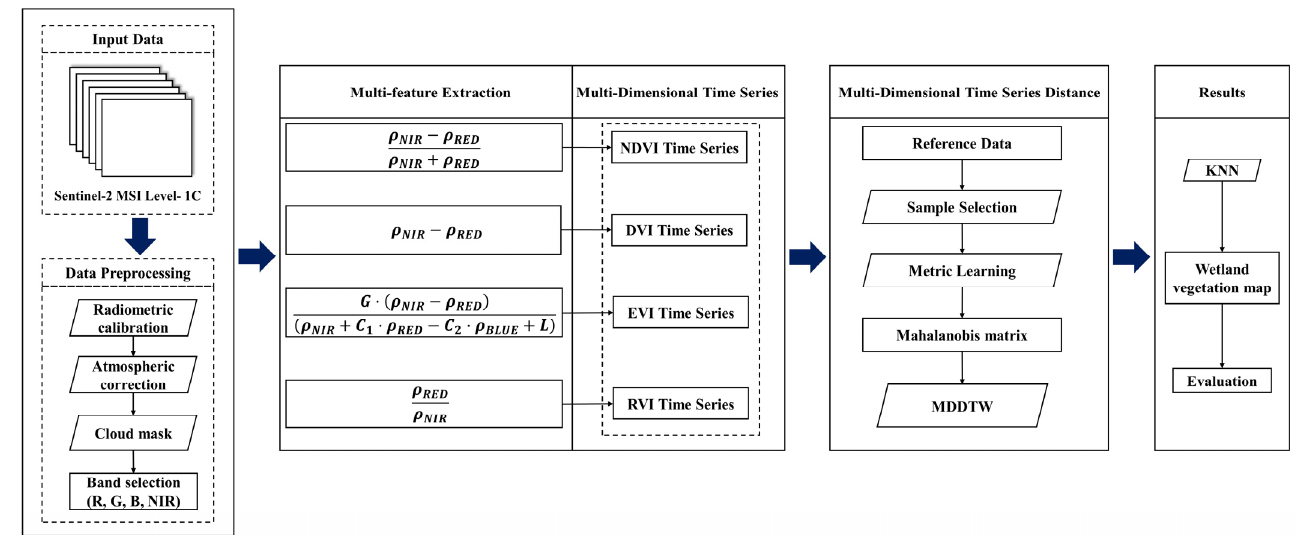
Figure 5. The workflow of KNN-MDDTW classification.